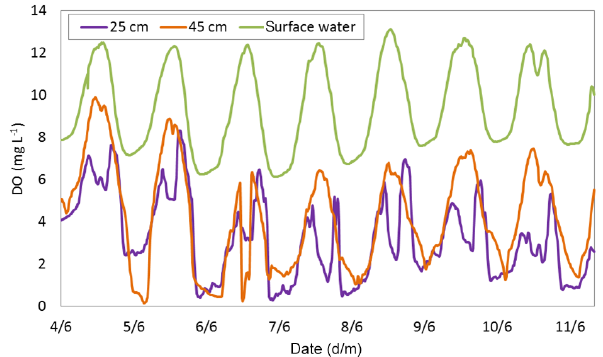
Figure 4. Time series of dissolved oxygen concentrations in the surface water (green) and the subsurface water (depth 25cm, purple; depth 45cm, orange) at the study site from 4–11 June